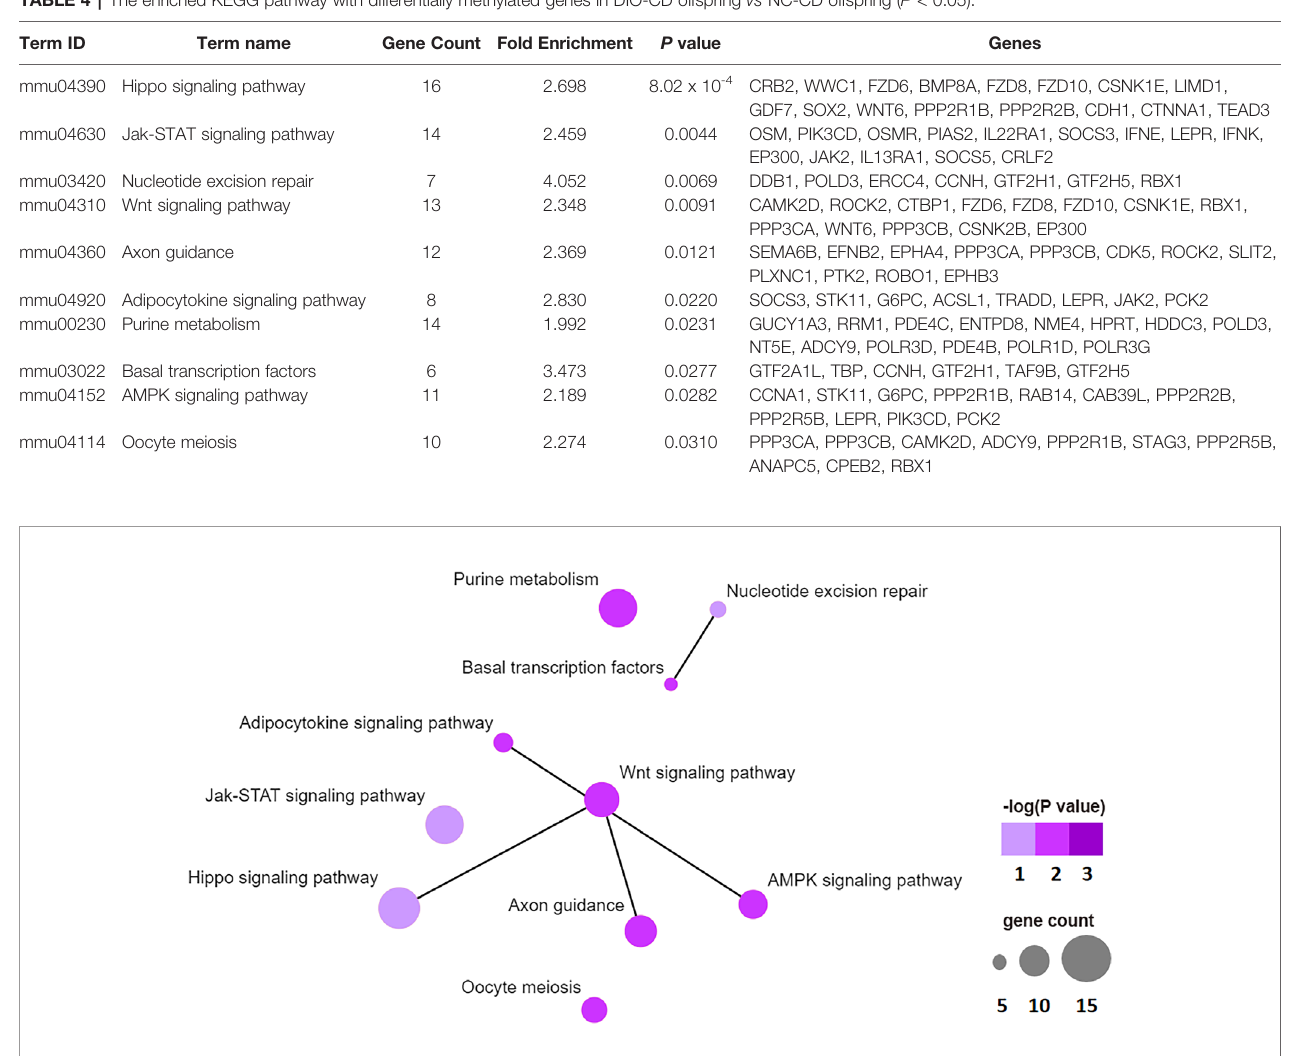
FIGURE 6 | Top 10 signi fi cant enriched KEGG pathway network, like hippo signaling pathway, Jak-STAT signaling pathway, nucleotide excision repair, WNT signaling pathway, axon guidance, adipocytokine signaling pathway, purine metabolism, basal transcription factors, AMPK signaling pathway, oocyte